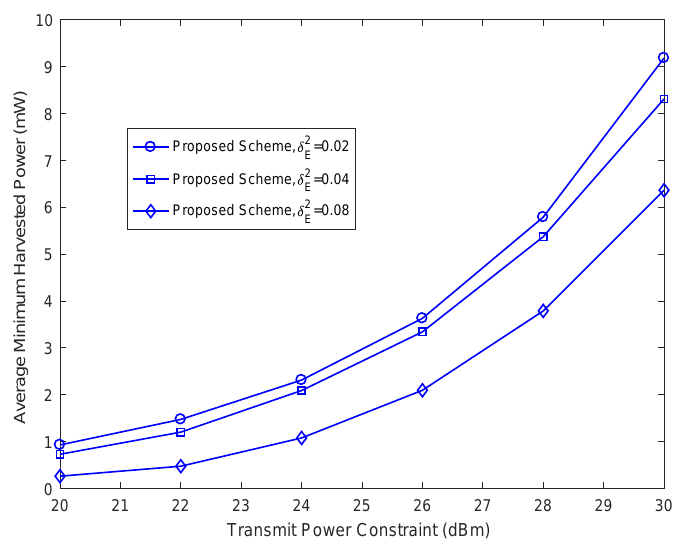
Figure 3. Average minimum harvested power per energy vehicular receiver versus total transmit power P with different δ 2 . E